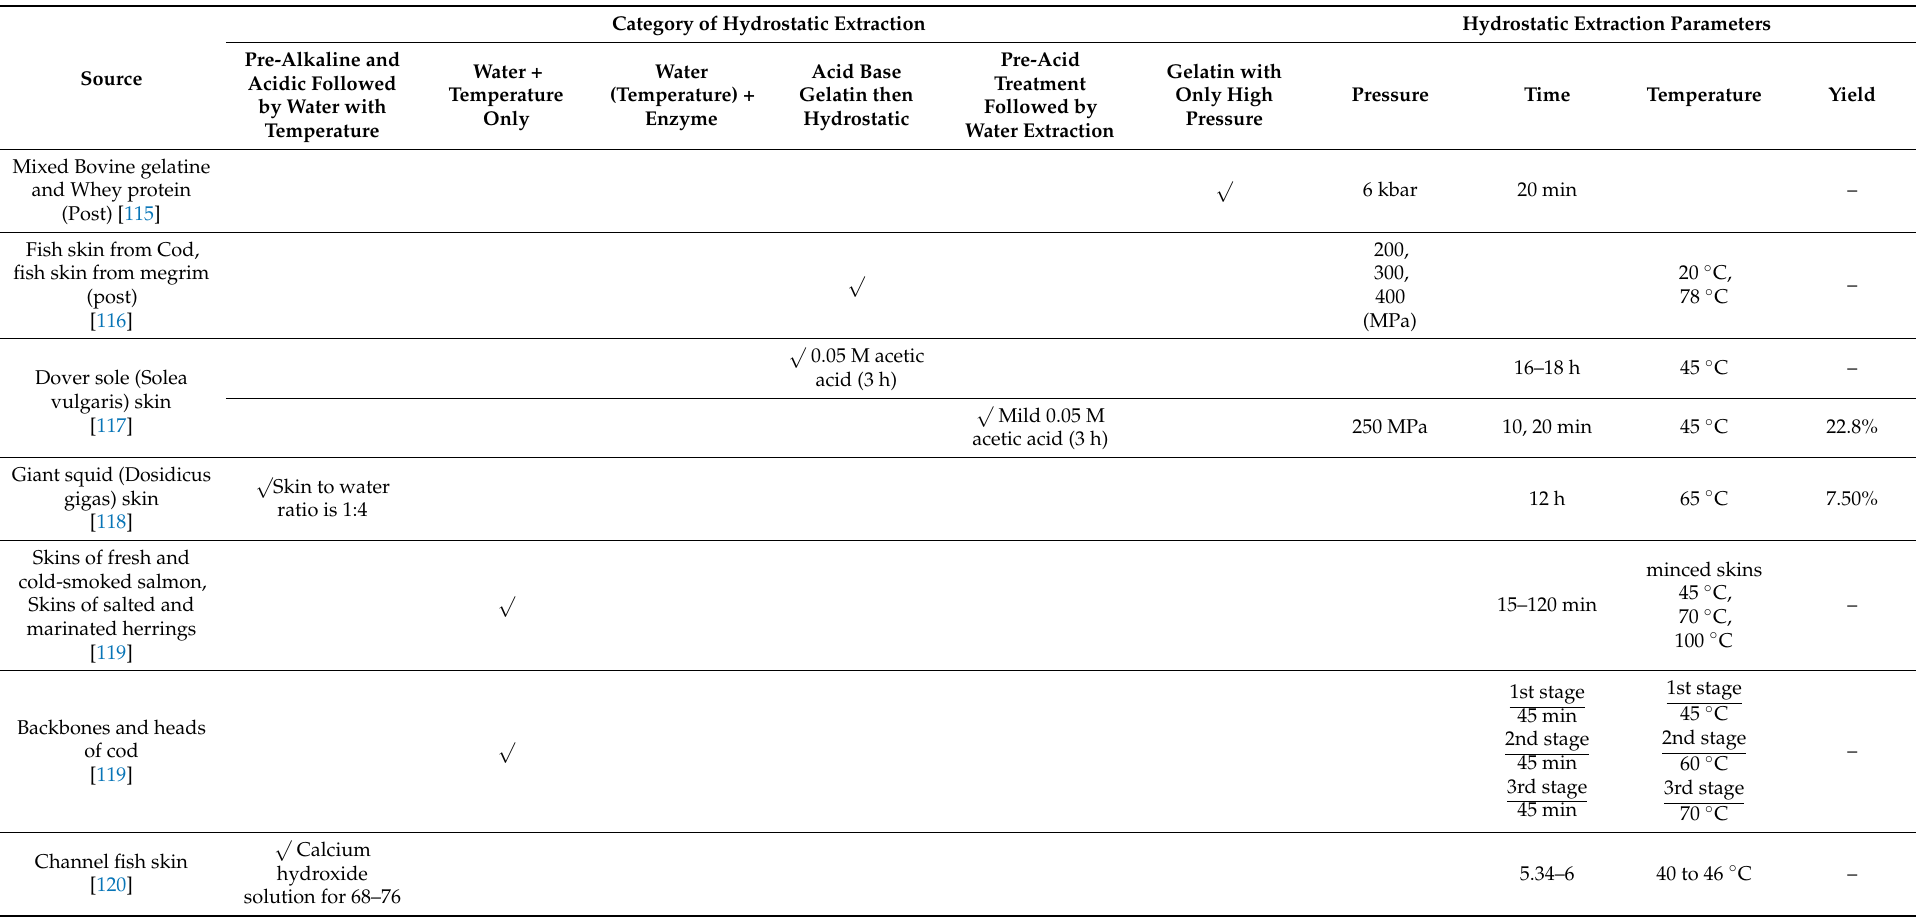
Table 7. Water extraction process for collagen